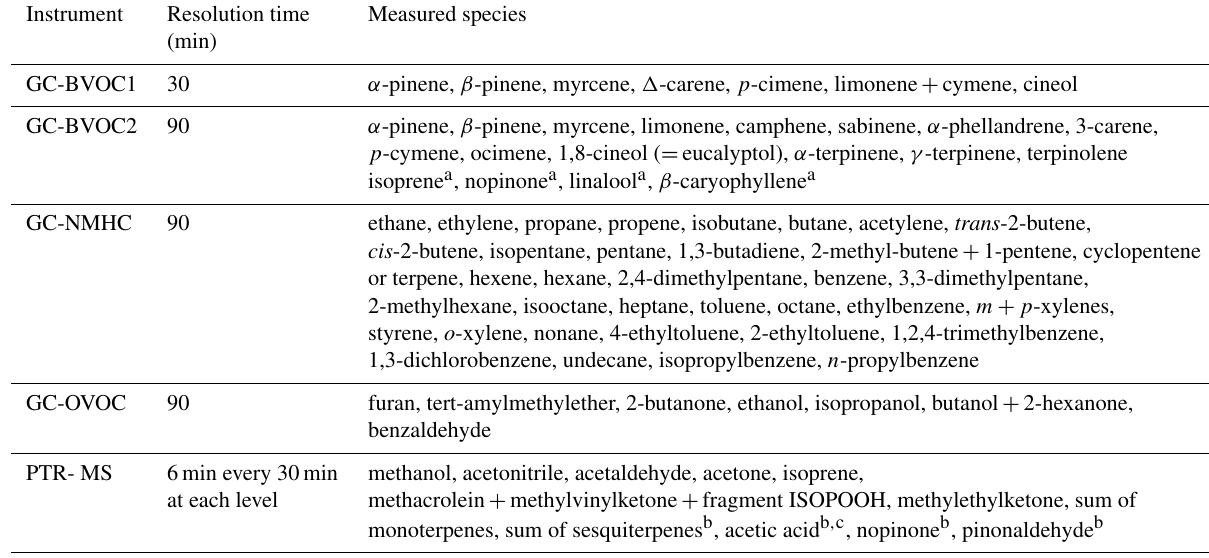
Table 3. Summary of supporting measurements performed inside and/or above the canopy.